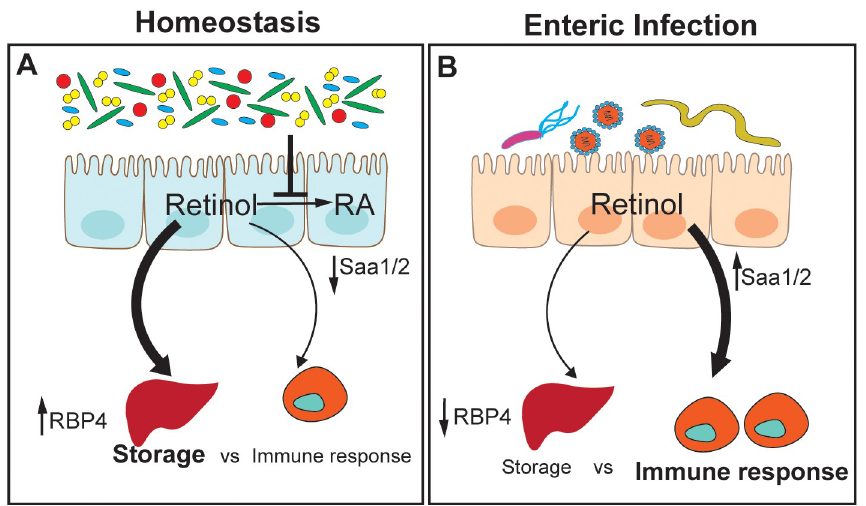
Fig 1. Vitamin A (retinol) handling during health and disease. (A) During homeostasis, gut bacteria suppress the conversion of dietary retinol into RA and promote its storage. Retinol transporter RBP4 is the main transporter of retinol to and from the liver. (B) During infection, RBP4 amounts drop, reducing retinol transport and storage in the liver. Acute-phase RBPs, such as SAAs, increase in the intestinal tissue and up-regulate local immune response to infection. RA, retinoic acid; RBP, retinol-binding protein; SAA, serum amyloid